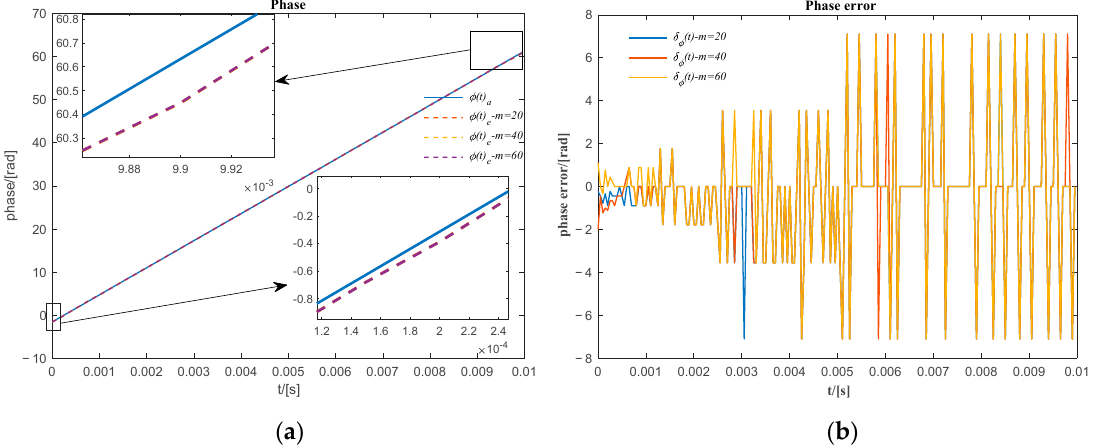
Figure 2. ( a ) The actual unwrapped phase and the extracted unwrapped phase using the first two sub-signals; ( b ) the phase error of the unwrapped phase extracted using the sum of the first two sub-signals.